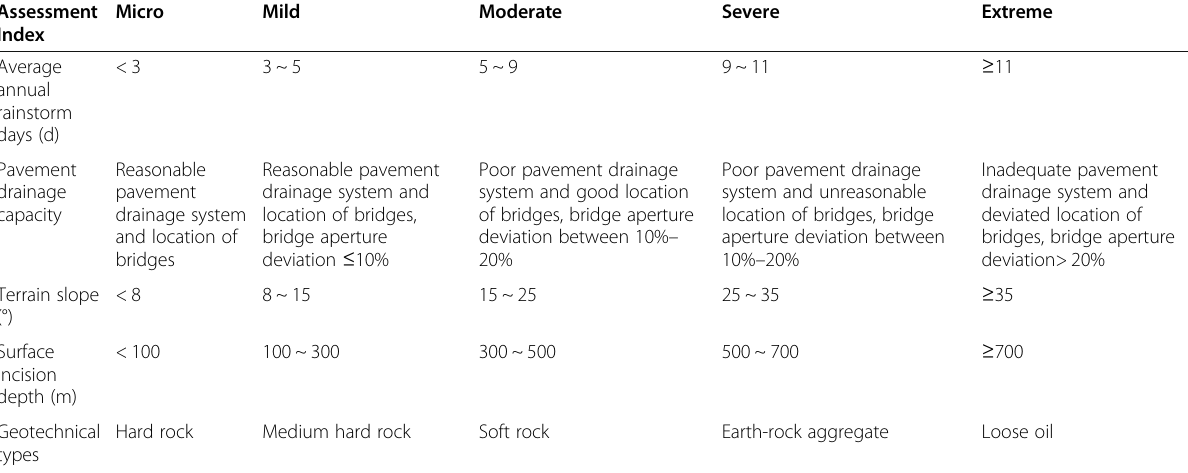
Table 4 Assessment standard of extreme rainfall climate in cold